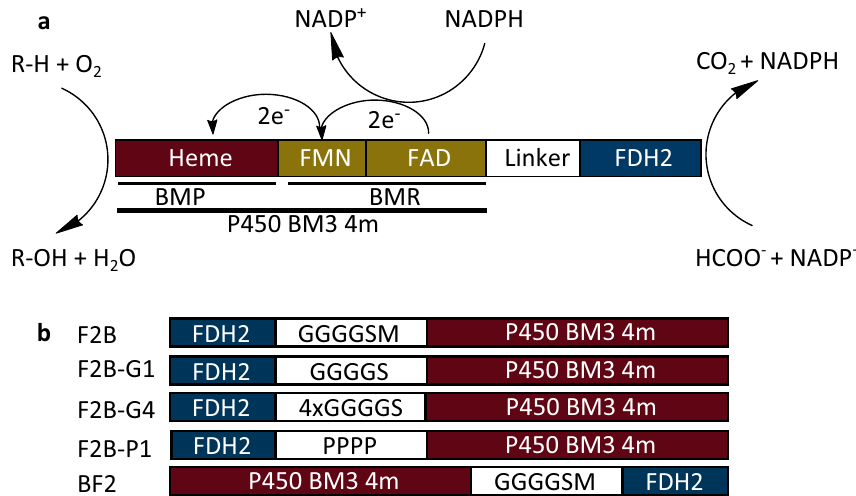
Figure 1. Design of enzyme fusions of BM3 4m and FDH2. ( a ) Detailed architecture and reaction scheme of the P450 BM3-FDH fusions as exemplified by the fusion construct with the enzyme order BF2 (real sizes of the enzymes are not considered). The formate dehydrogenase FDH2 (blue colored) catalyzes the oxidation of HCOO − to CO 2 and reduction of NADP + to NADPH. Cytochrome P450 consists of a BMP and BMR domain. The BMR domain (greenish colored) contains an FAD cofactor which partakes in the oxidation of NADPH to NADP + and transfers two electrons to FMN, and an FMN cofactor which transfers the electrons (2 × e − ) to the BMP domain (red colored). Subsequent substrate hydroxylation occurs at the active site of the BMP domain which contains heme and reduces O 2 to water upon substrate hydroxylation. In the fusion enzyme, BM3 4m and FDH2 are bridged by a linker (white colored). ( b ) Schematic diagram for the constructed fusions with FDH2 (blue colored) positioned at the N-terminal and BM3 4m (red colored) positioned at the C-terminal (enzyme order F2B) and vice versa (enzyme order BF2). Short amino acid linkers are illustrated through the white box with the noted amino acids describing the composition of the linkers. The fusion constructs F2B and BF2 contain the methionine of the enzyme at the C-terminal position which was removed in the fusion constructs F2B-G1, F2B-G4 and F2B-P1.